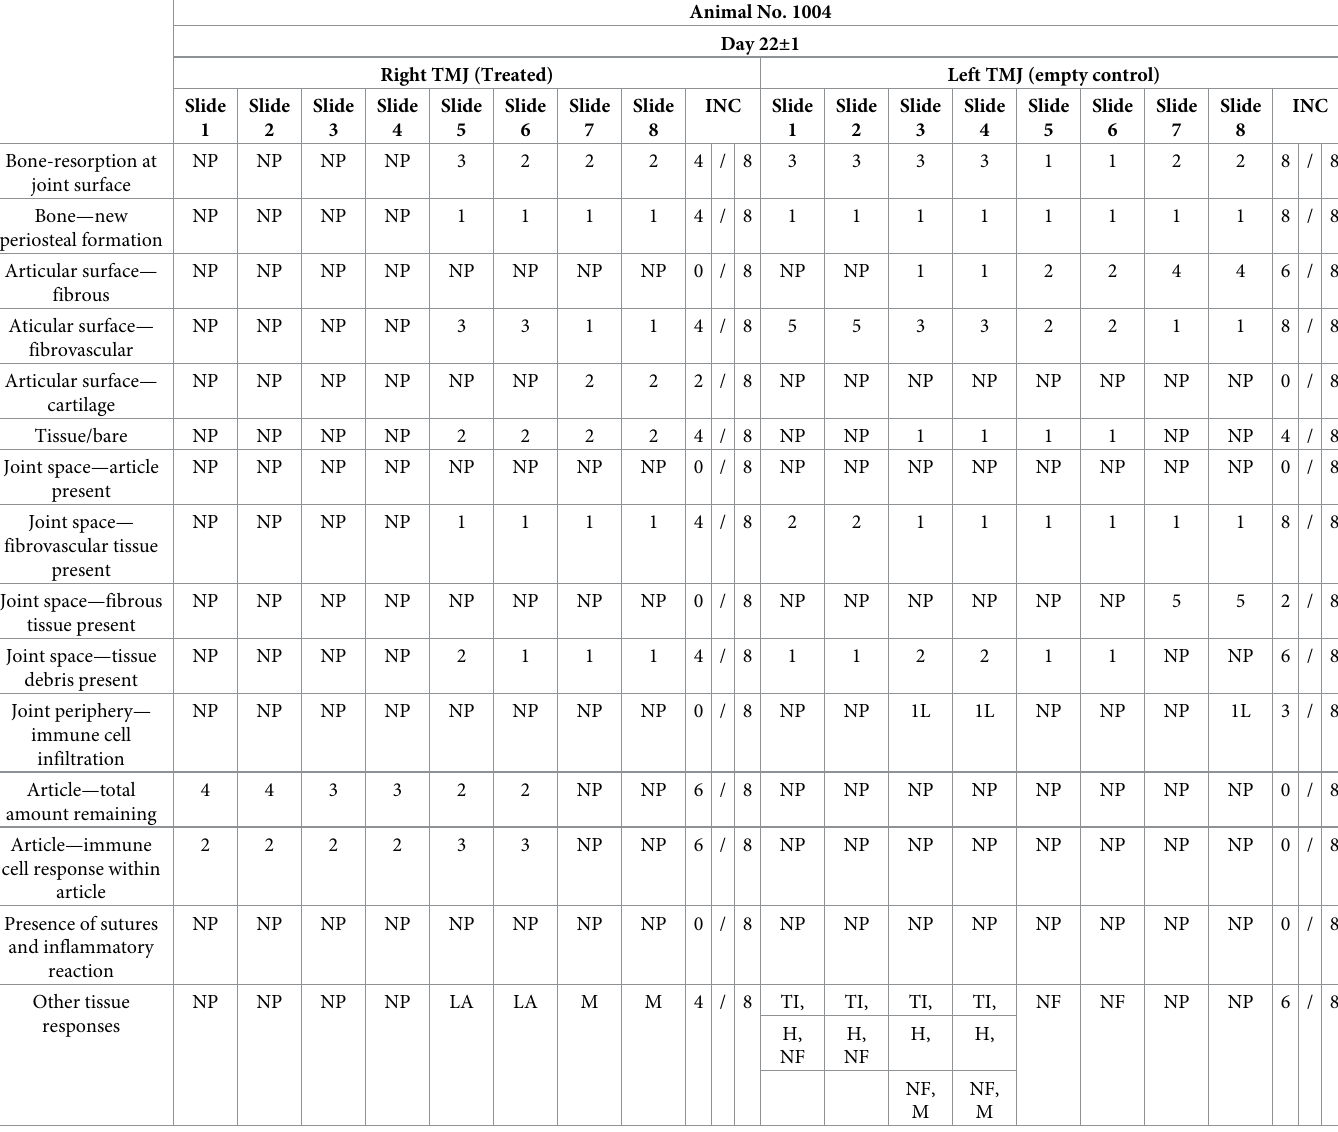
Table 11. Individual histopathological findings for animal